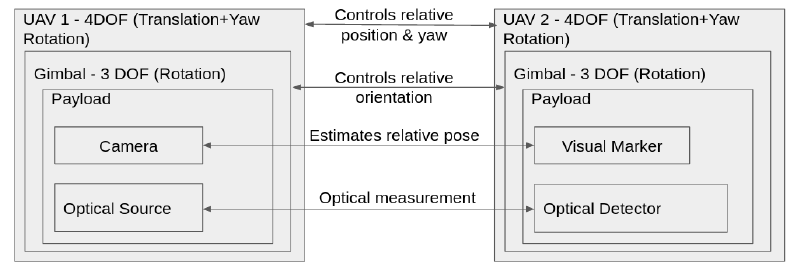
Figure 2. Engineering concept of formation flying UAVs for a distributed system for optical